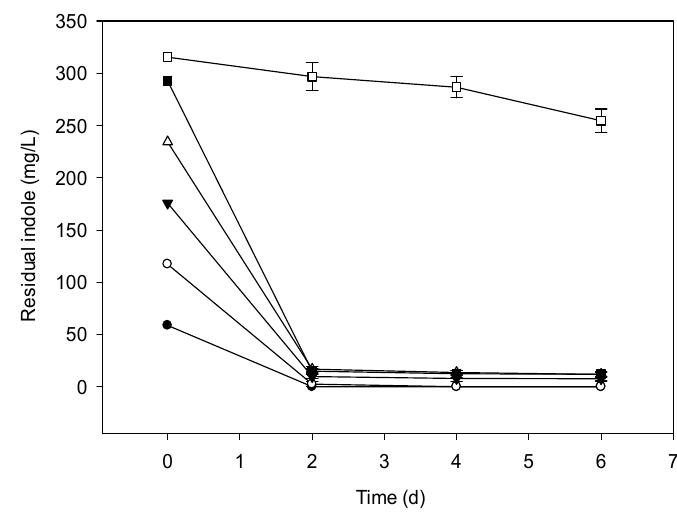
Figure 3. Indole removal capability of a mix of two strains (NTA1-2A and TAT1-6A) at different initial concentrations (mg/L). Symbols: Solid circle, 58.58; open circle, 117.15; solid triangle, 175.73; open triangle, 234.30; solid square, 292.87; open square, 351.45; error bars, mean ± SE of three replicates at 31 °C and pH 6.